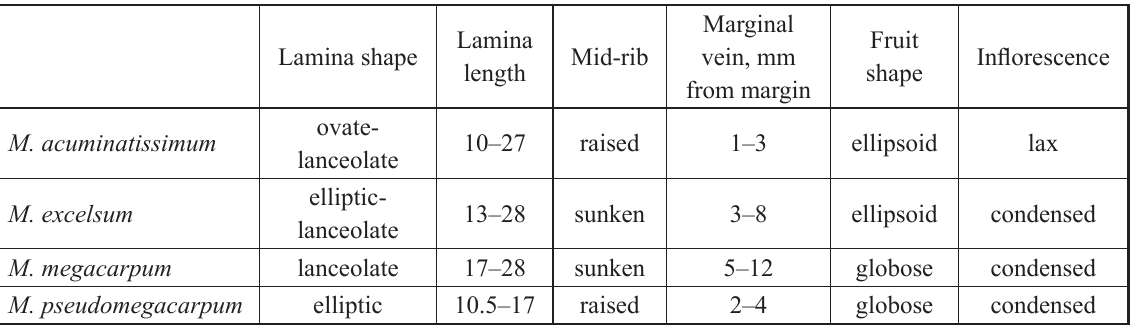
Table 1. Summary of diagnostic characters for M. pseudomegacarpum and similar